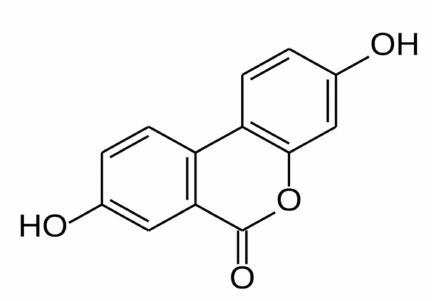
Figure 2. Chemical structure of urolithin